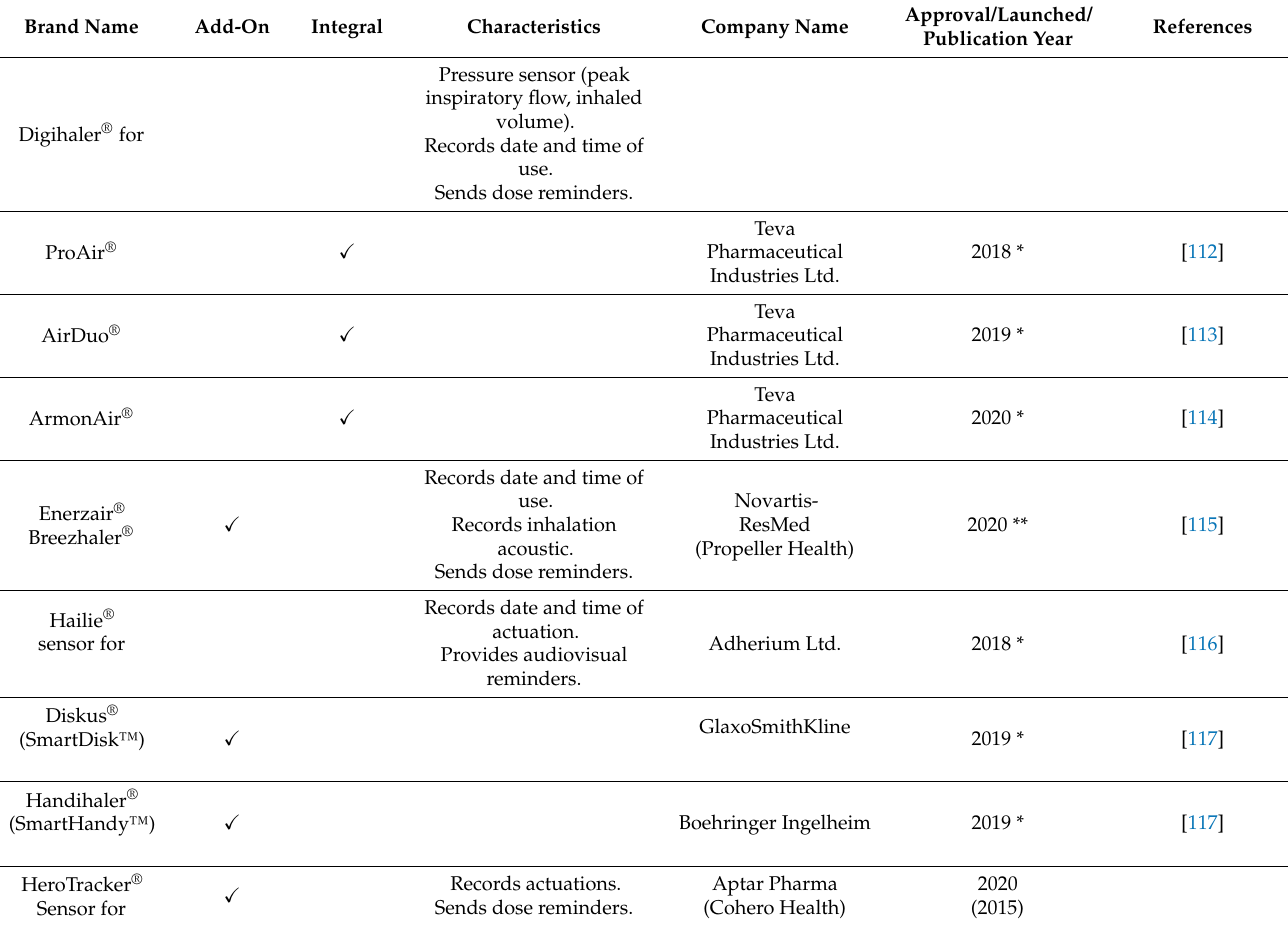
Table 2. Marketed and under-development digitalized DPIs in alphabetical order (first rows are dedicated to marketed products; not intended to be fully